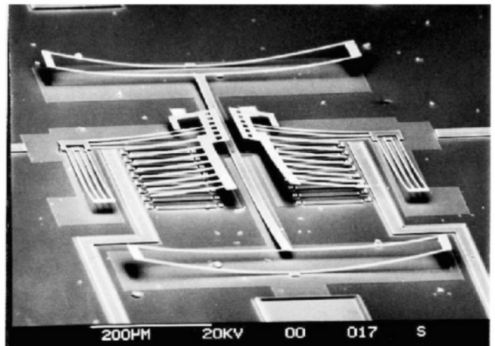
Figure 4. Effect of residual stress on free-standing structure. Reproduced with permission from Ref. [21].